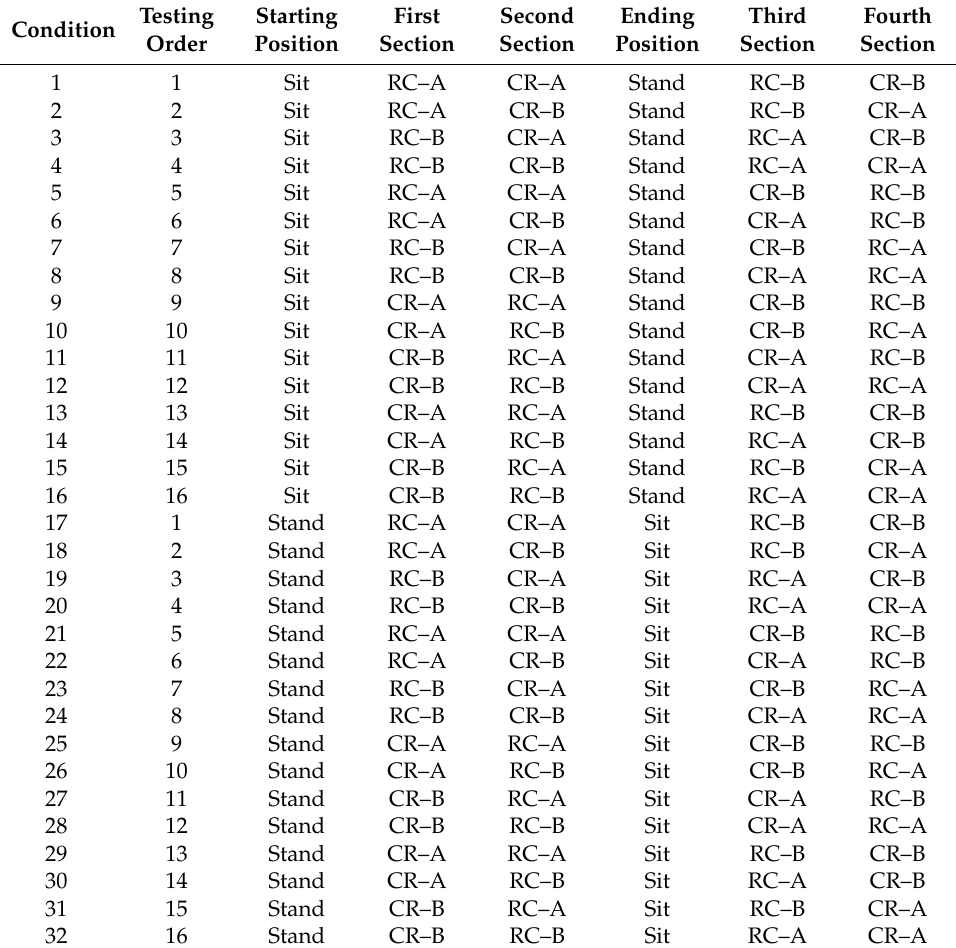
Table 1. Counterbalancing of Body Position and Testing